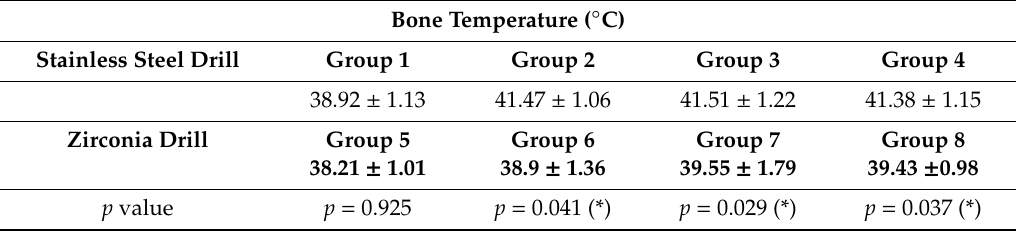
Table 1. Summary of the cortical bone temperature after drilling site preparation (mean ± standard deviation) (* p <